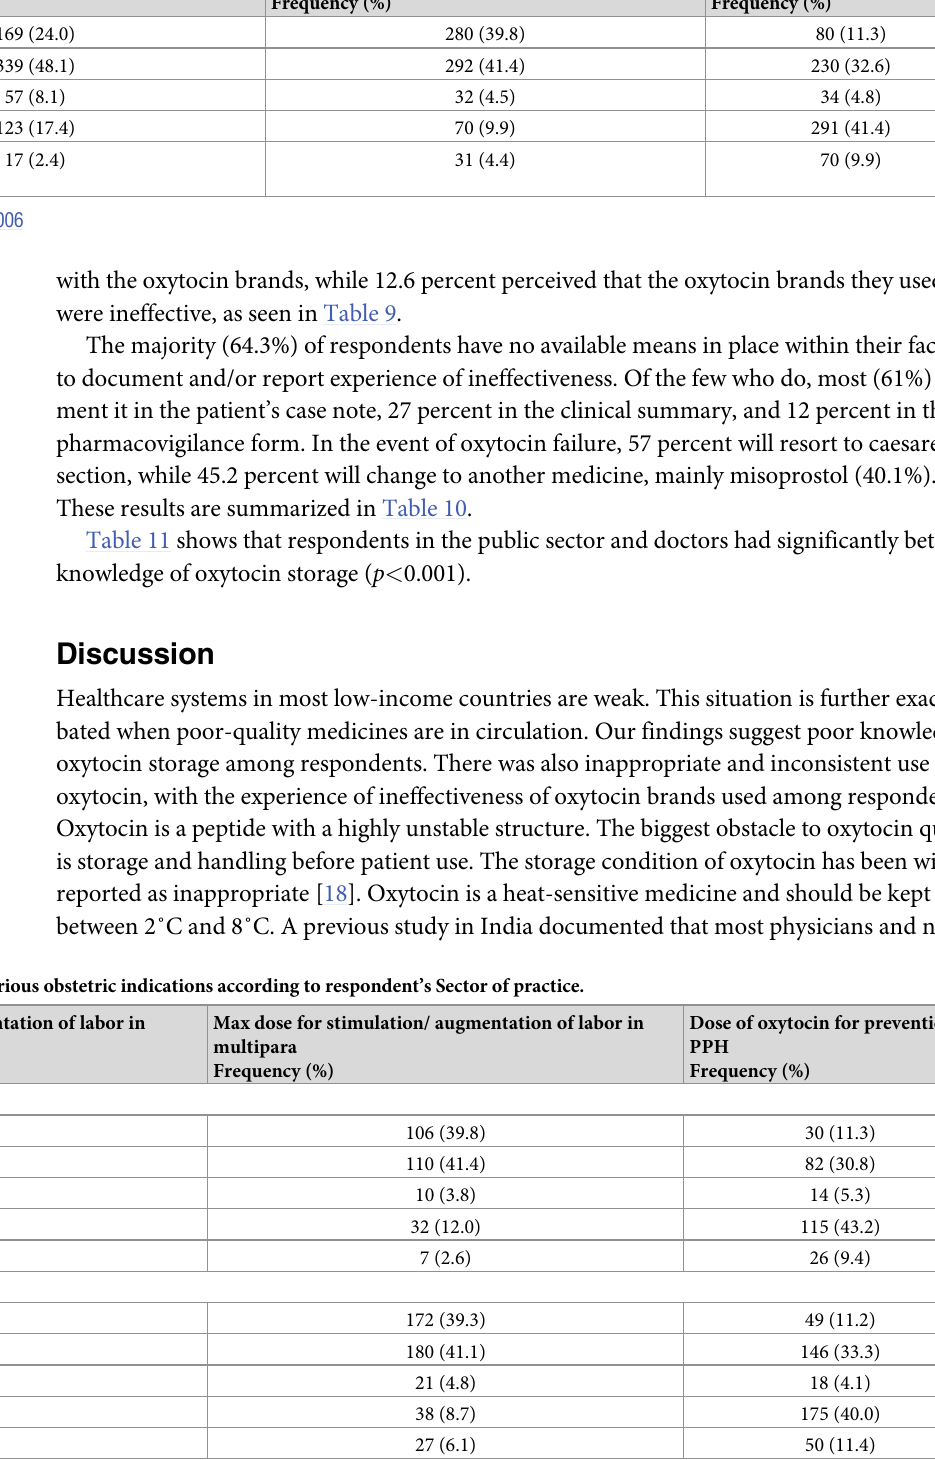
Max dose for stimulation/ augmentation of labor in